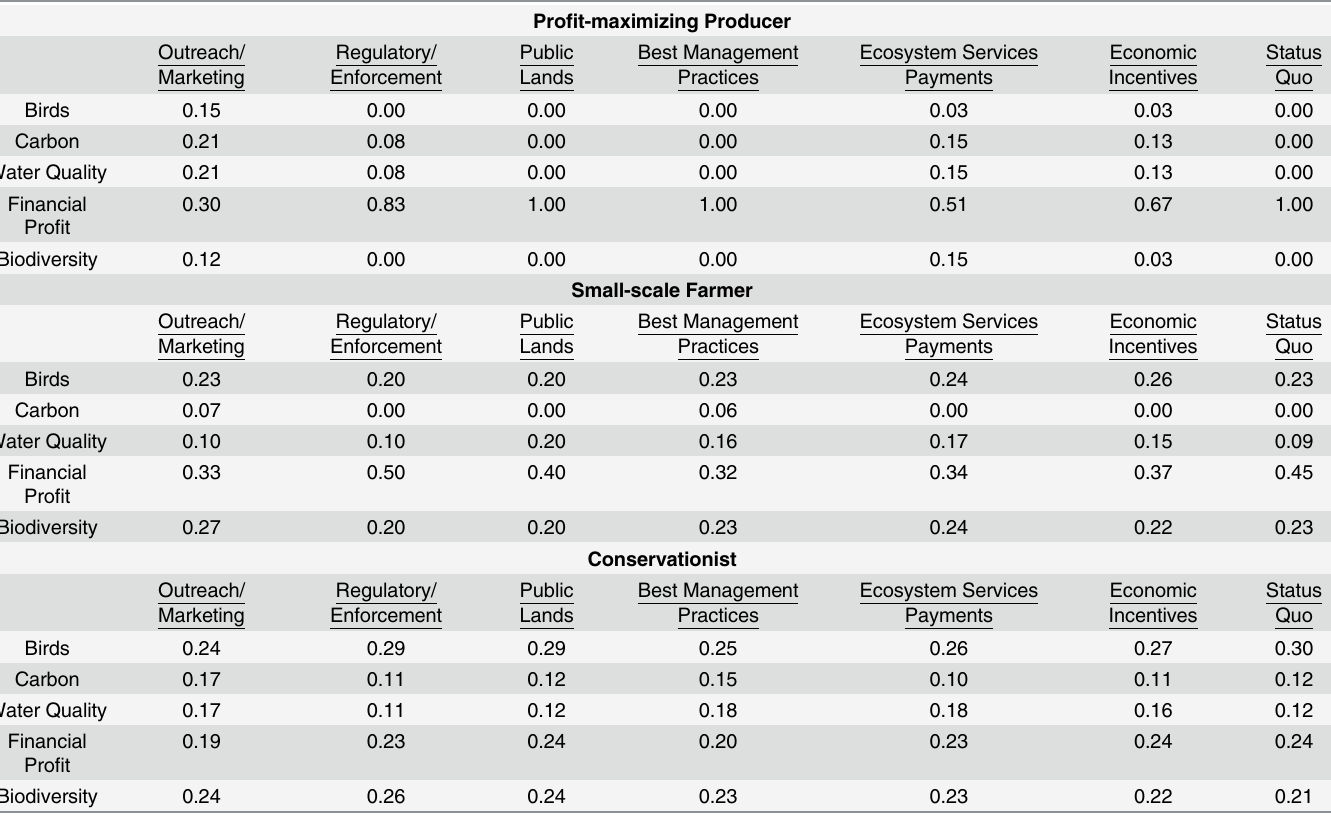
Table 1. Preference weights for each landowner type, for each objective and policy. Weights were used to evaluate land cover choices for each land- owner and were based on the opinions of workshop participants. Future applications of this approach could incorporate empirical social science data to inform the value weightings of an agent-based